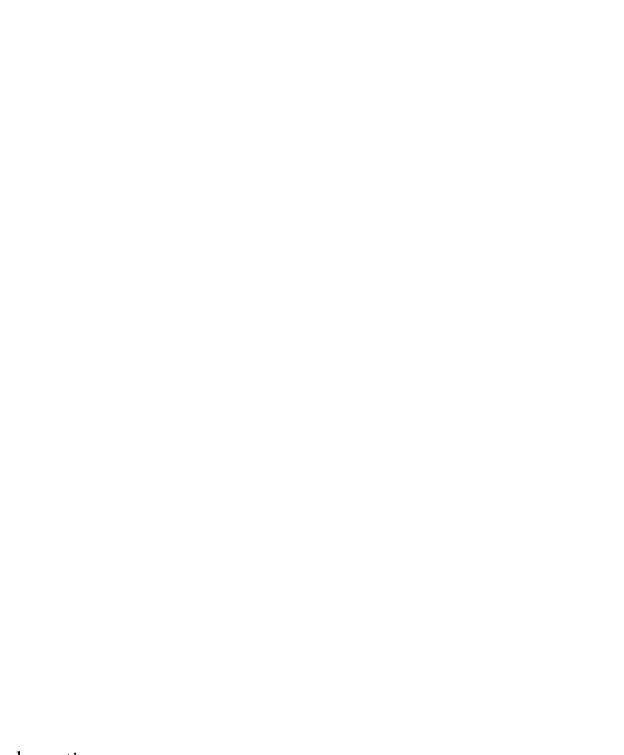
Figure 6. ShuffleNetV2 channel splitting